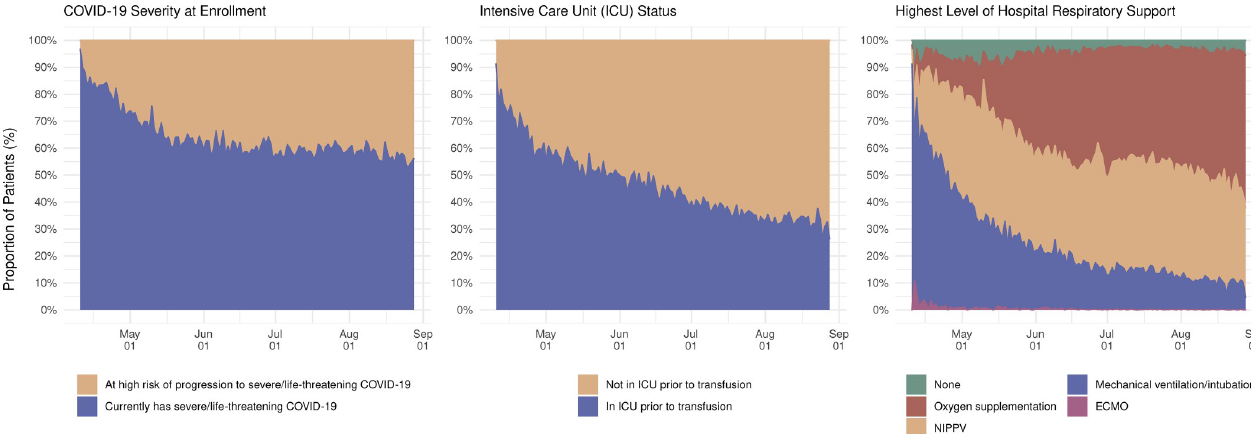
Fig 6. Daily patient enrollment in the US Expanded Access Program (EAP) relative to COVID-19 patient symptomatology. Stacked area chart displaying daily rates of patient enrollment in the EAP as a proportion of the sum total daily enrollment stratified by patient symptomatology, including 2 categories of COVID-19 disease severity, dichotomous representation of intensive care unit (ICU) status, and categorical level of respiratory support prior to COVID-19 convalescent plasma transfusion (none, oxygen supplementation, noninvasive positive-pressure ventilation [NIPPV], mechanical ventilation, or extracorporeal membrane oxygenation [ECMO]). Only patients who received a COVID-19 convalescent plasma transfusion are included in the 2 rightmost panels.